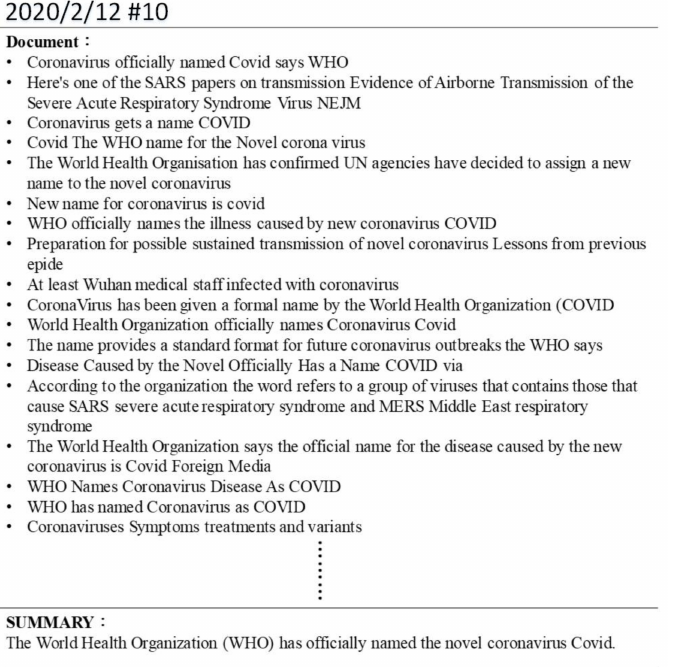
Figure A5. A sample resulting summary of formulated event topics (12 February